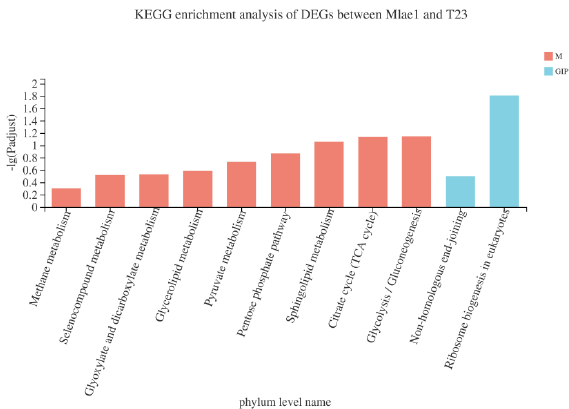
Figure 3. GO enrichment analysis of DEGs between Mlae1 and T23 strains.